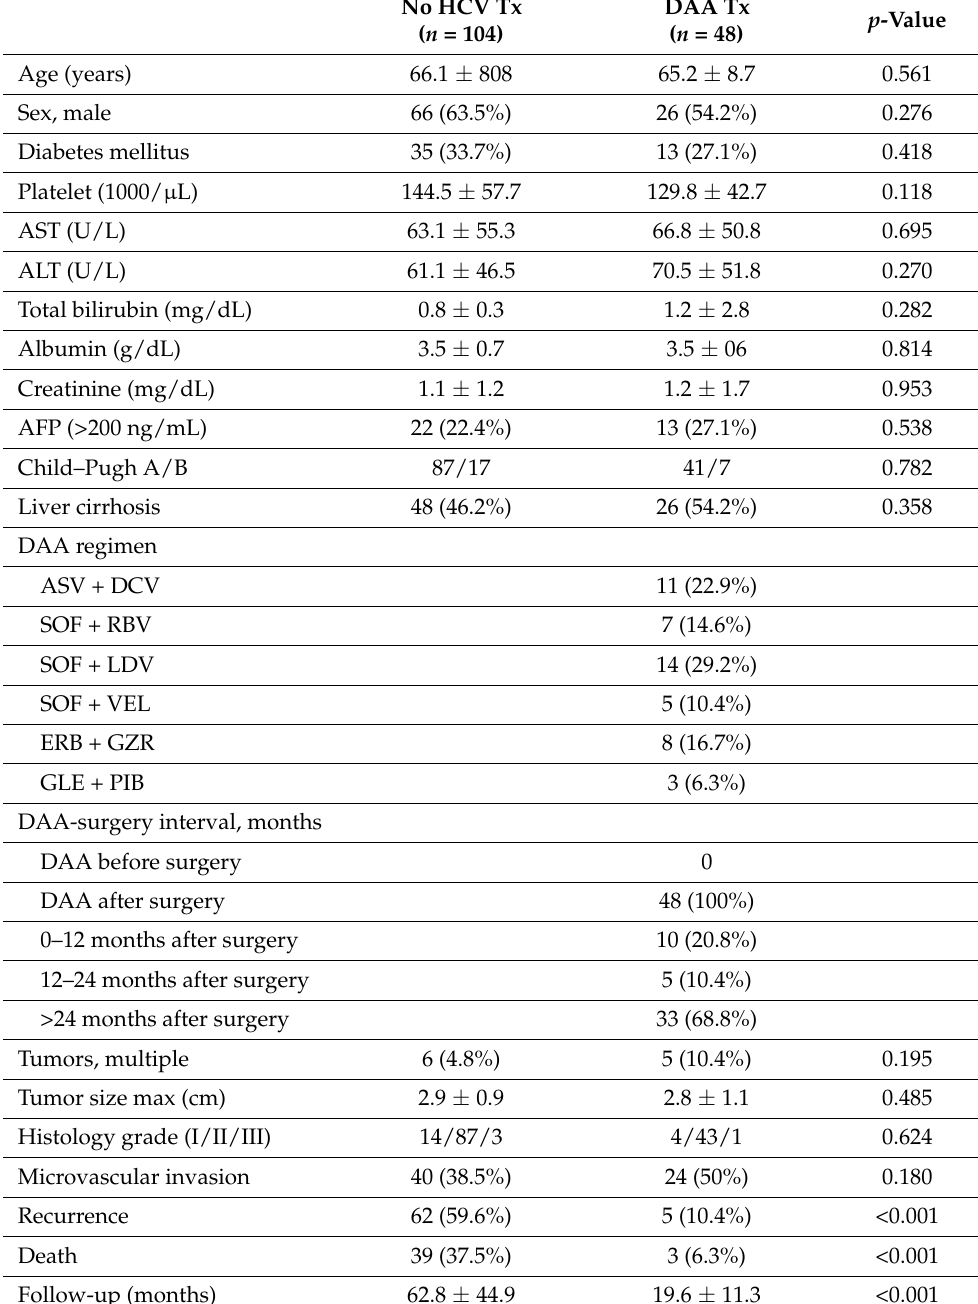
Table 1. Characteristics of the study